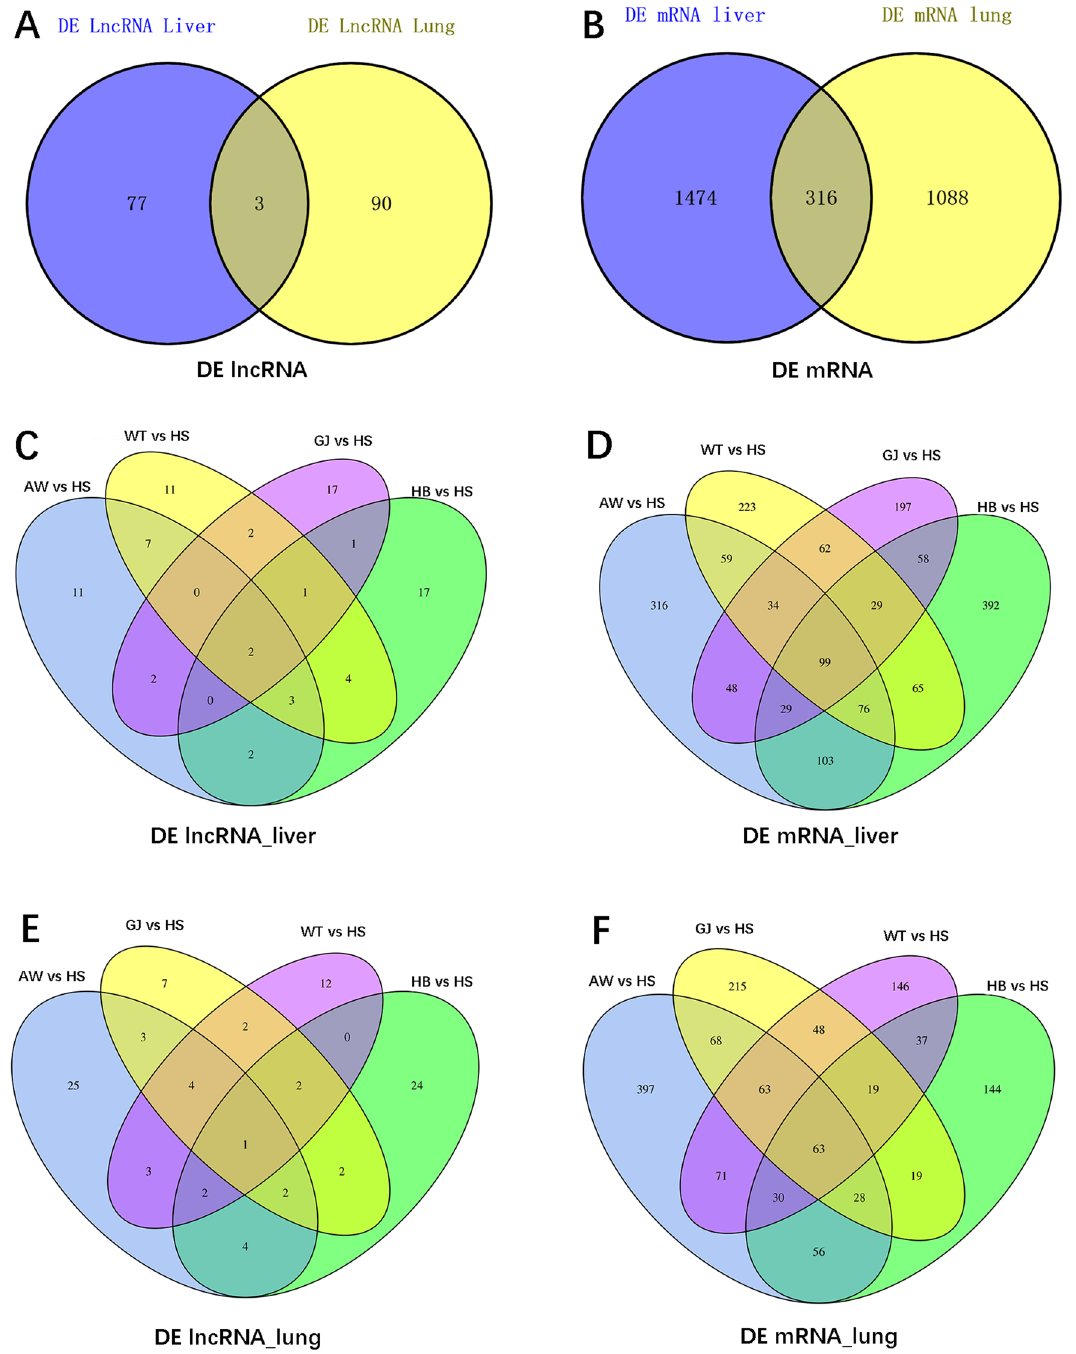
Figure 4. Venn diagram of common differential expression genes. ( A ) The common DE lncRNAs in pairwise comparison between lung and liver tissue. ( B ) The common DE mRNAs in pairwise comparison between lung and liver tissue. ( C ) The common DE lncRNAs in four comparison groups of liver samples (AW vs. HS, HB vs. HS, GJ vs. HS, WT vs. HS). ( D ) The common DE mRNAs in four comparison groups of liver samples (AW vs. HS, HB vs. HS, GJ vs. HS, WT vs. HS). ( E ) The common DE lncRNAs in four comparison groups of lung samples (AW vs. HS, HB vs. HS, GJ vs. HS, WT vs. HS). ( F ) The common DE mRNAs in four comparison groups of lung samples (AW vs. HS, HB vs. HS, GJ vs. HS, WT vs.